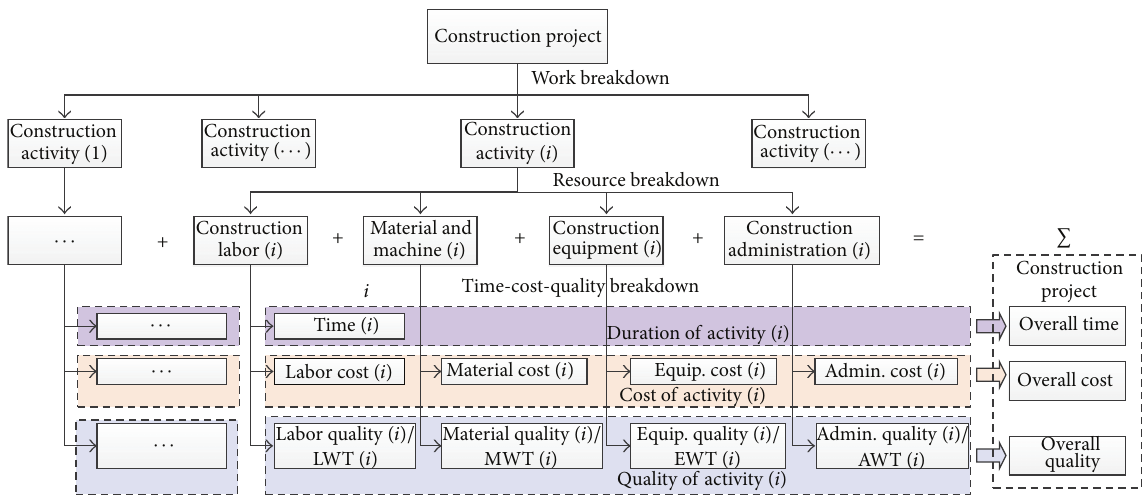
Figure 1: Breakdown and formation structure of time-cost-quality in a construction project essential relationships among the time, cost, and quality parameters in construction activities are assumed and discussed as